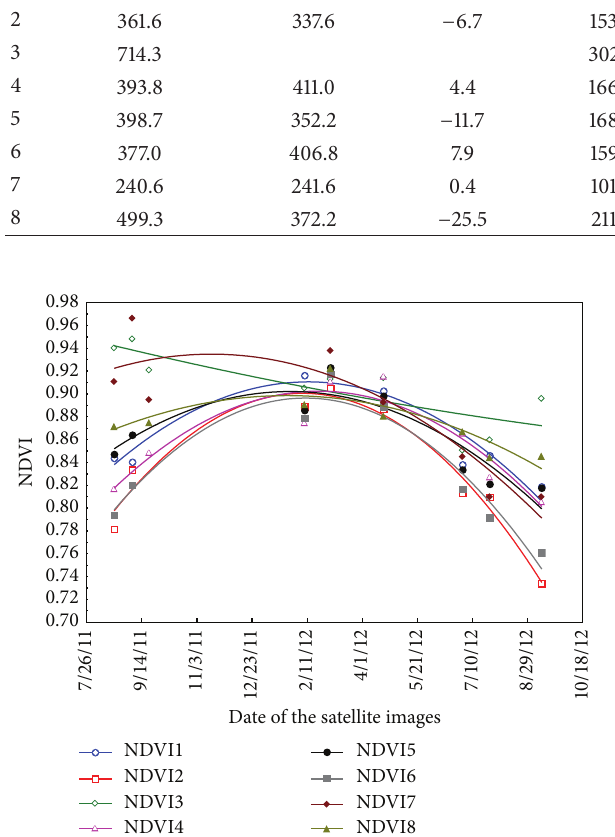
Figure 9: NDVI with second-degree polynomial tendency for each